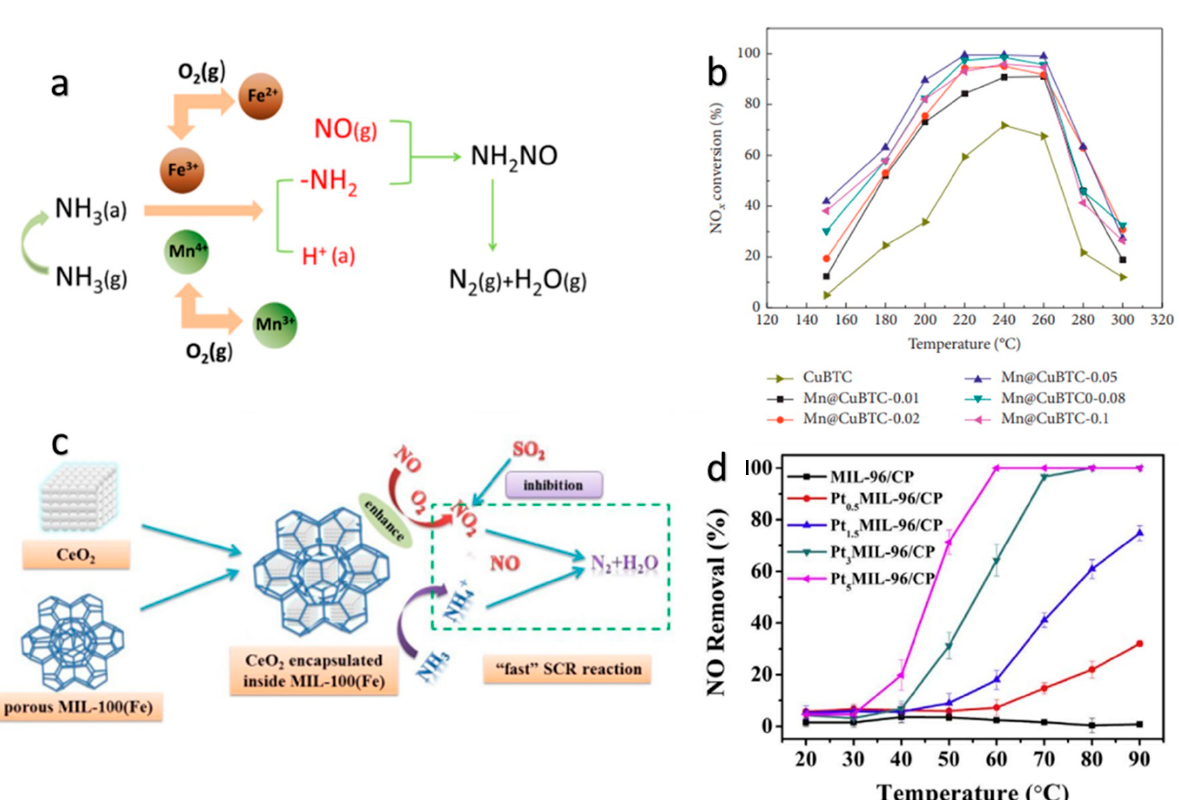
Figure 3. Bimetallic MOFs catalysts for NO x SCR, ( a ) Fe-Mn [21] (copyright 2022 Springer Nature), ( b ) Mn-Cu [23] (copyright 2019 Hindawi), ( c ) Ce-Fe [24] (copyright 2016 Elsevier), ( d ) Pt-Al [25] (copyright 2018 Elsevier).